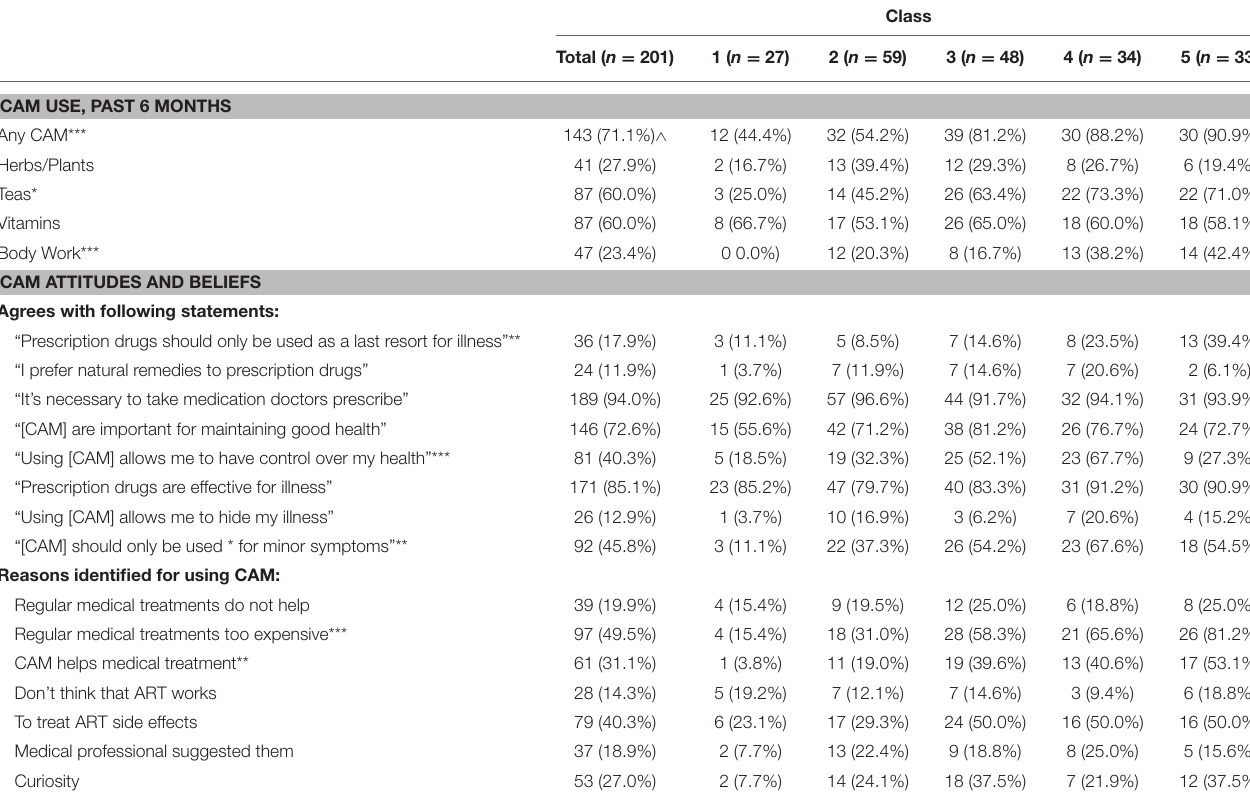
TABLE 3 | CAM utilization and related attitudes and beliefs (by